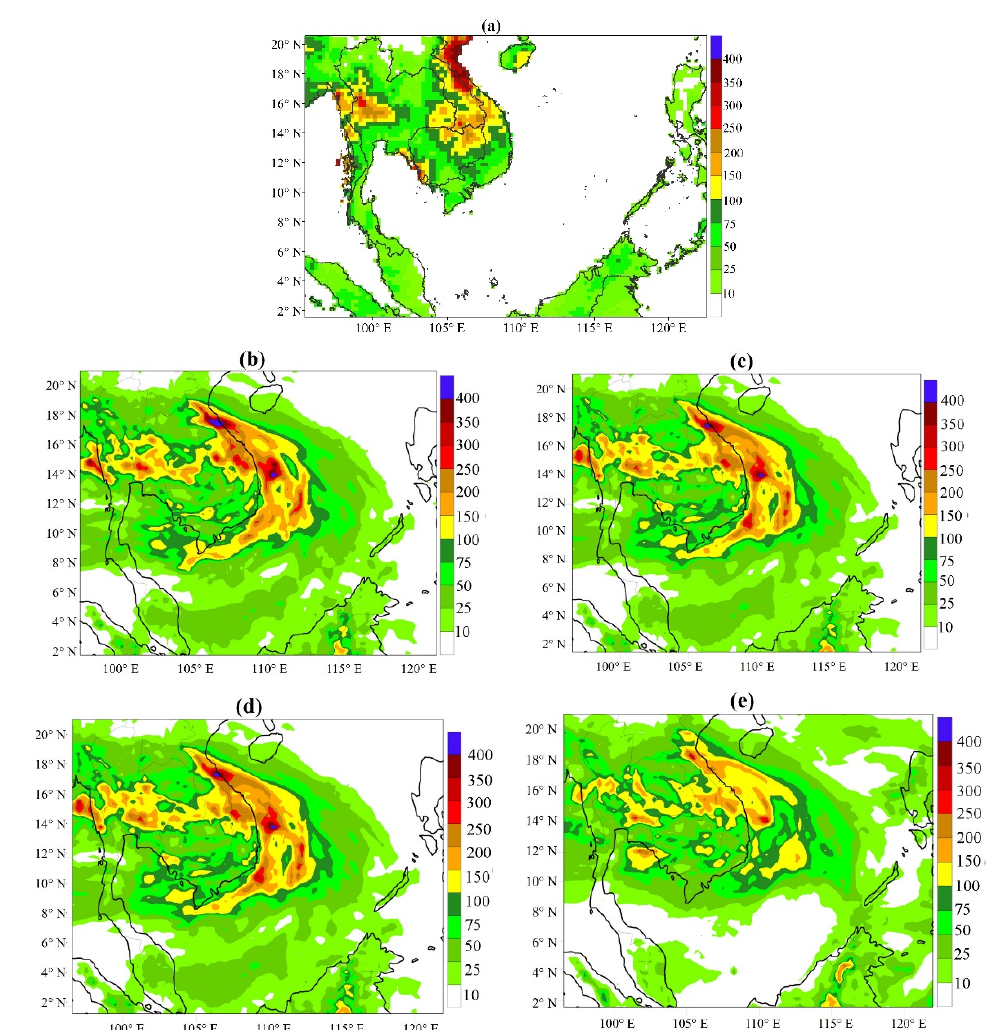
Figure 7. Spatial distribution of 72-h accumulated rainfall given by ( a ) CHIRPS analysis, ( b ) ALL-OBS, ( c ) RDA1, ( d ) RDA2, and ( e ) CNTL.